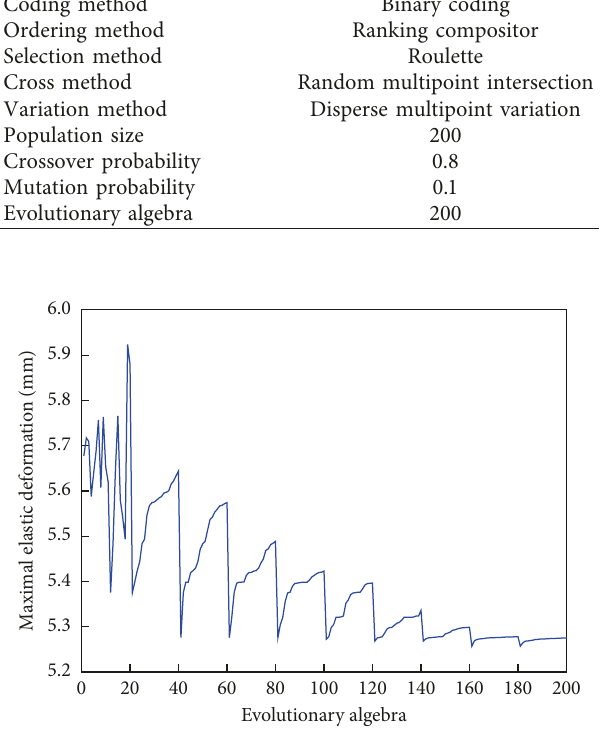
Figure 15: The iterative histories for objective function.